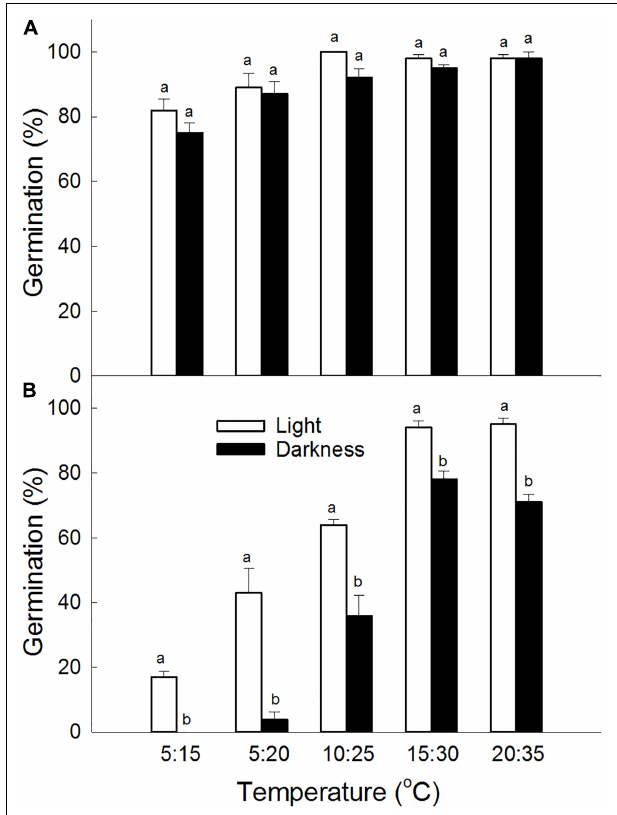
FIGURE 1 | Effect of light condition and temperature regime on germination percentage of (A) brown and (B) black seeds of S. salsa . For each treatment there were four biological replicates. Different lower-case letters indicate significant differences in germination percentages between dimorphic seeds at the same temperature.